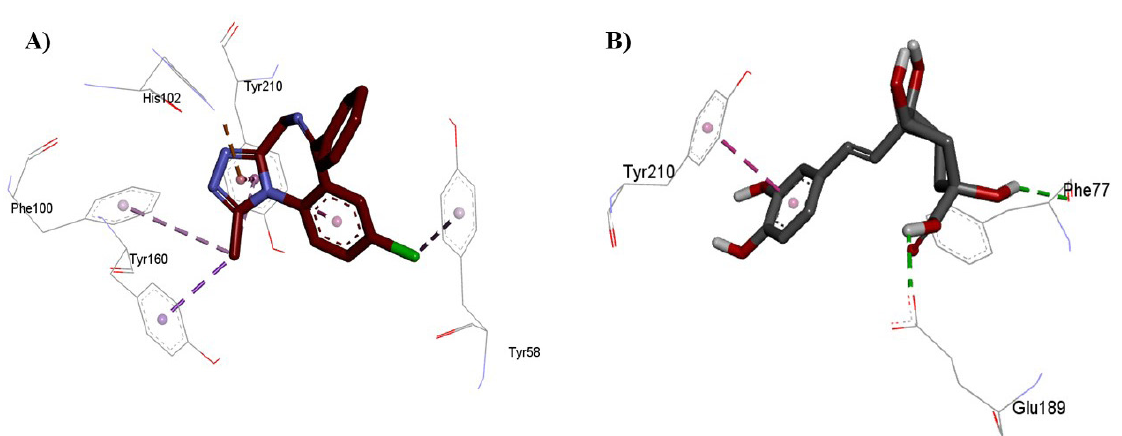
FIGURE 2 - The binding interactions between the ligands and GABAA. A) Alprazolam B) Chlorogenic acid. Hydrogen bonds are presented by green, Pi-alkyl by pink, Pi-cation by orange, Pi-sigma by violet and Pi-Pi stacking interactions by magenta dotted